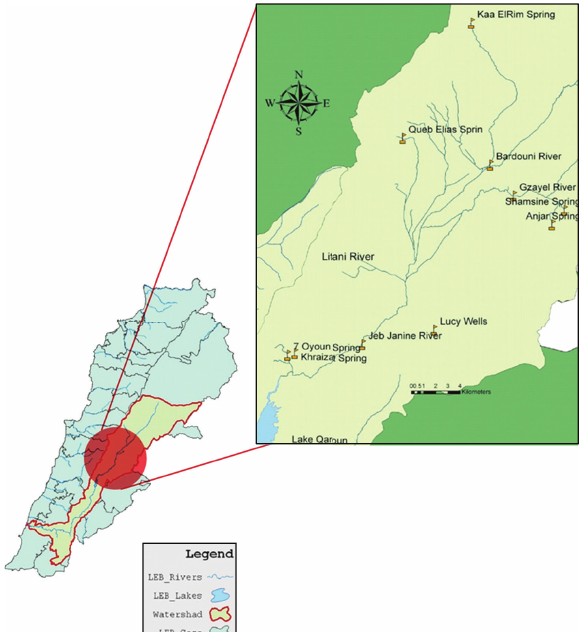
Figure 1: Sampling points in the upper Litani River Basin.